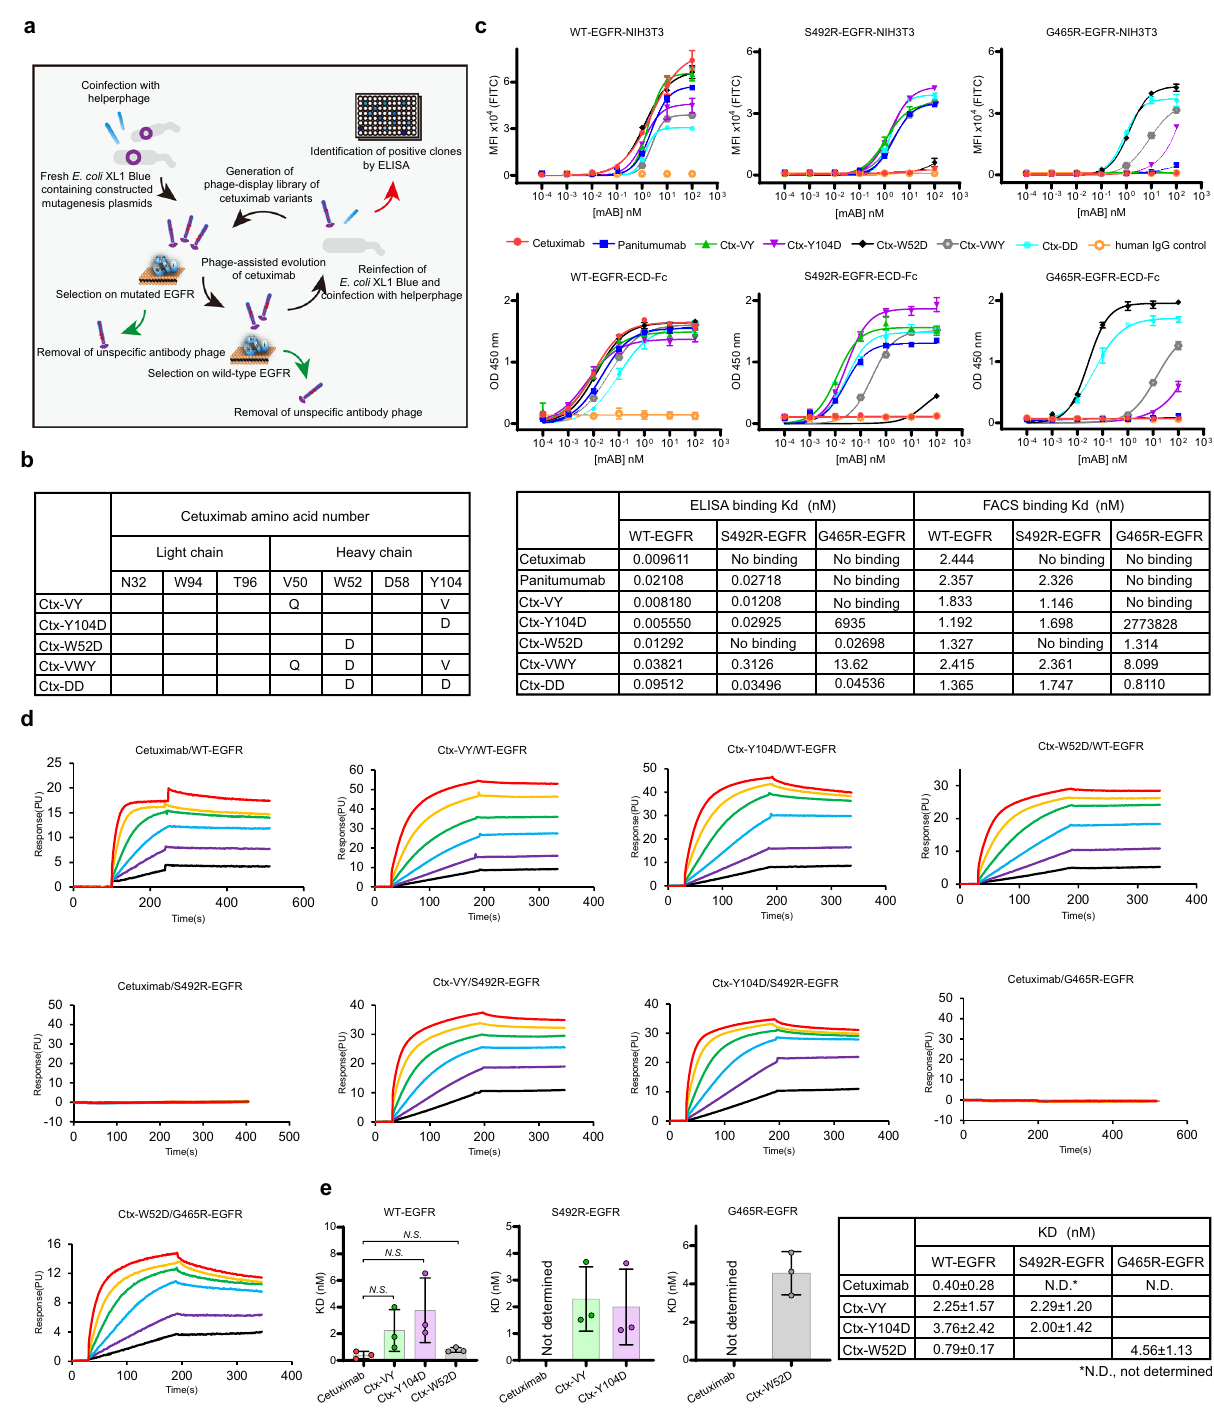
Fig. 4 | Identi fi cation and characterization of the evolved cetuximab variants. a Schematic diagram of phage-assisted cetuximab evolution. b Summary of the mutations responsive to directed evolution of cetuximab to reverse EGFR S492R - or EGFR G465R - mediated resistance. c The binding ability of cetuximab and its variants with (top panel) NIH3T3 cells expressing EGFR WT or EGFR Mut (i.e., EGFR S492R and EGFR G465R )orwith(bottompanel)theWT-EGFR-ECD-FcorMut-EGFR-ECD-Fcfusion protein.NIH3T3cell-basedbindingassayswereperformedby fl owcytometry,while EGFR-ECD-Fc fusion protein-related binding assays were performed by ELISA. The